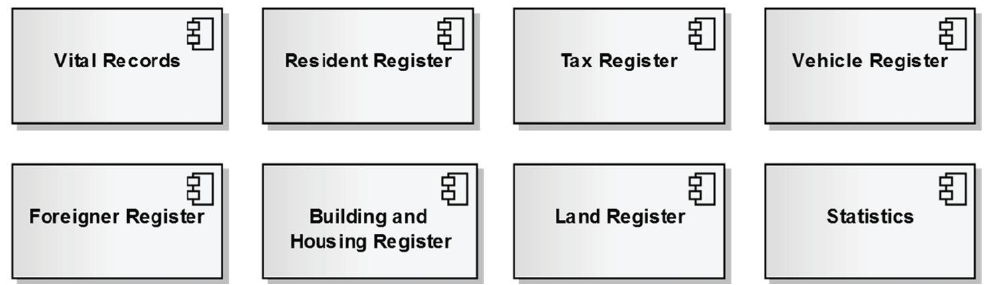
Figure 3. Examples of official data